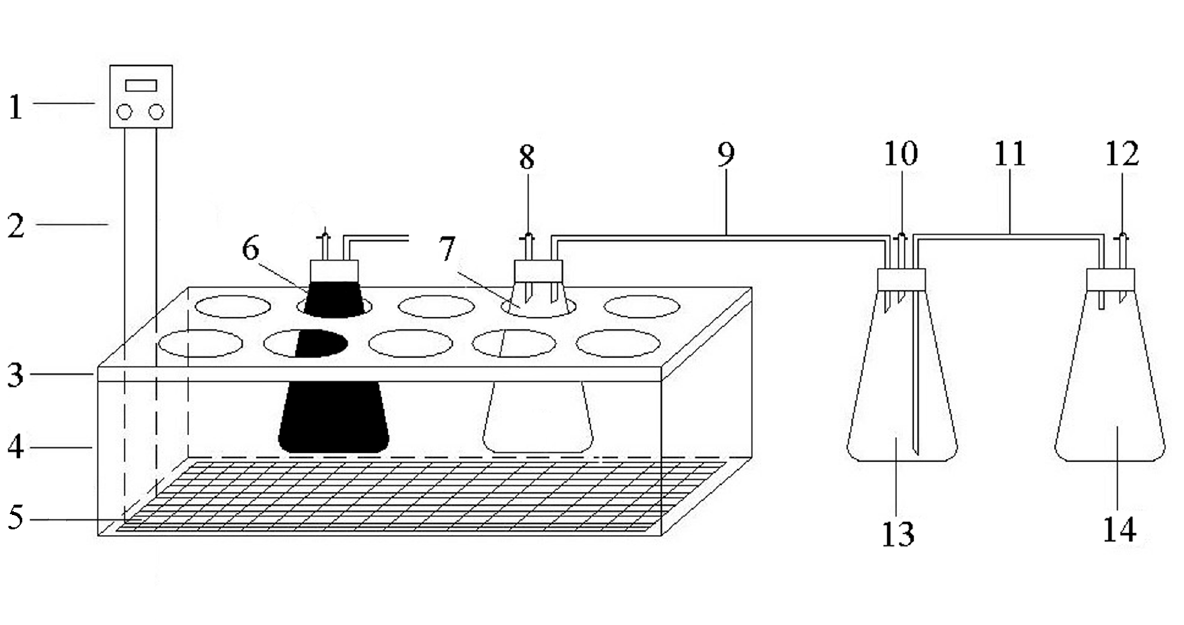
Fig 2. Controlled and constant temperature anaerobic fermentation device. 1. Temperature controlling box; 2. Temperature sensor; 3. Insulated cover; 4. Thermostatic water tank; 5. Strip heater; 6. None transparent digester; 7. Transparent digester; 8. Taking sampling; 9. Airway tube; 10. Taking biogas; 11. Aqueduct; 12. Air pipe; 13. Biogas collecting bottle; 14. Water collecting bottle.